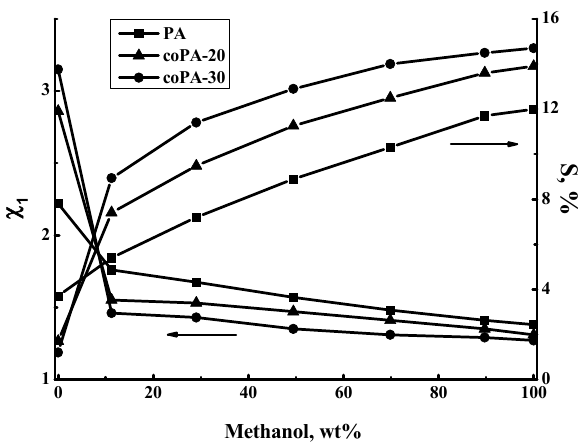
Figure 4. Dependence of equilibrium sorption degree and interaction parameter χ 1 on methanol concentration in methanol–toluene mixtures, 20 °C.